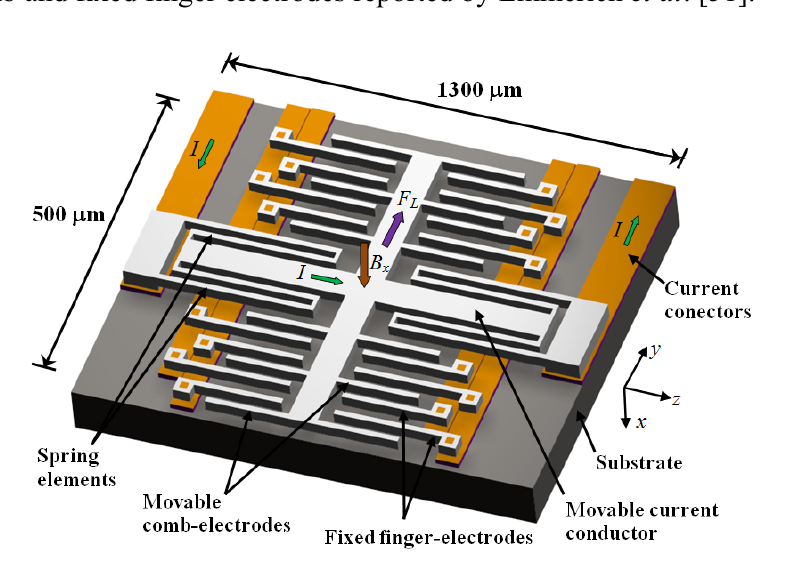
Figure 13. Schematic view (not to scale) of the resonant magnetic field sensor based on movable comb and fixed finger electrodes reported by Emmerich et al .